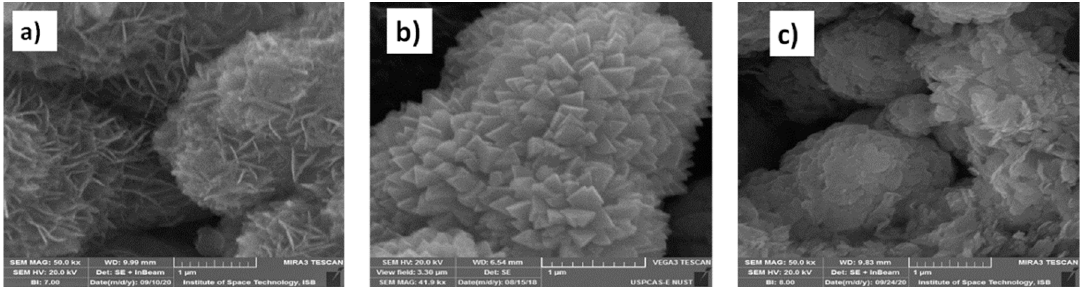
Figure 3. SEM images of ( a ) MoS 2 , ( b ) ZnSe and ( c ) 3:1 MZ at 1 µm scale.